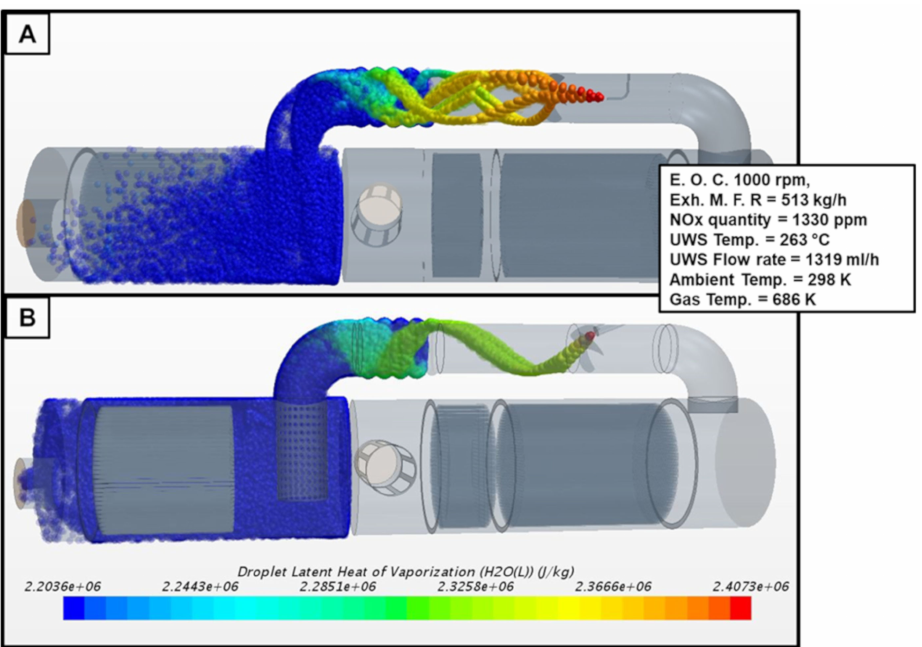
Figure 4. The urea vaporization values: ( A ) original urea injector; ( B ) suggested urea injector for Hyundai